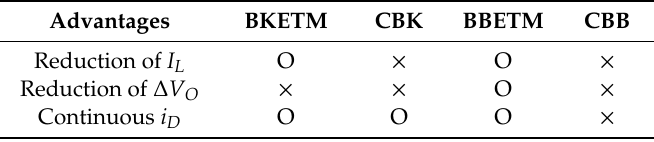
Table 5. Summary table with buck and buck-boost type converters.